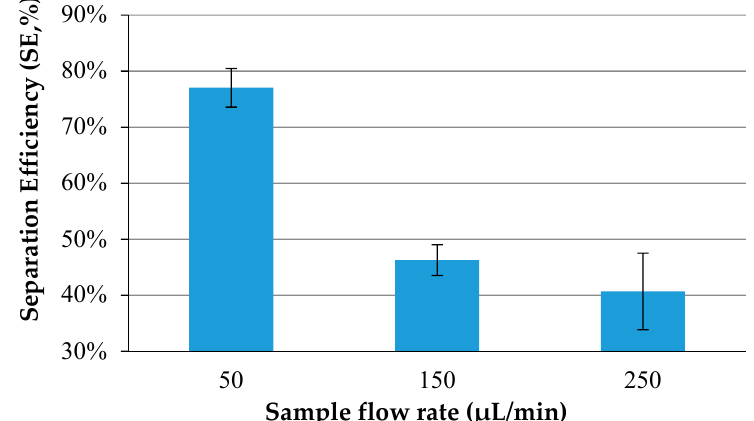
Figure 4. Separation efficiency of salmonella typhimurium at a concentration of 10 4 CFU/mL the using proposed device with different flow rates ( N = 3).